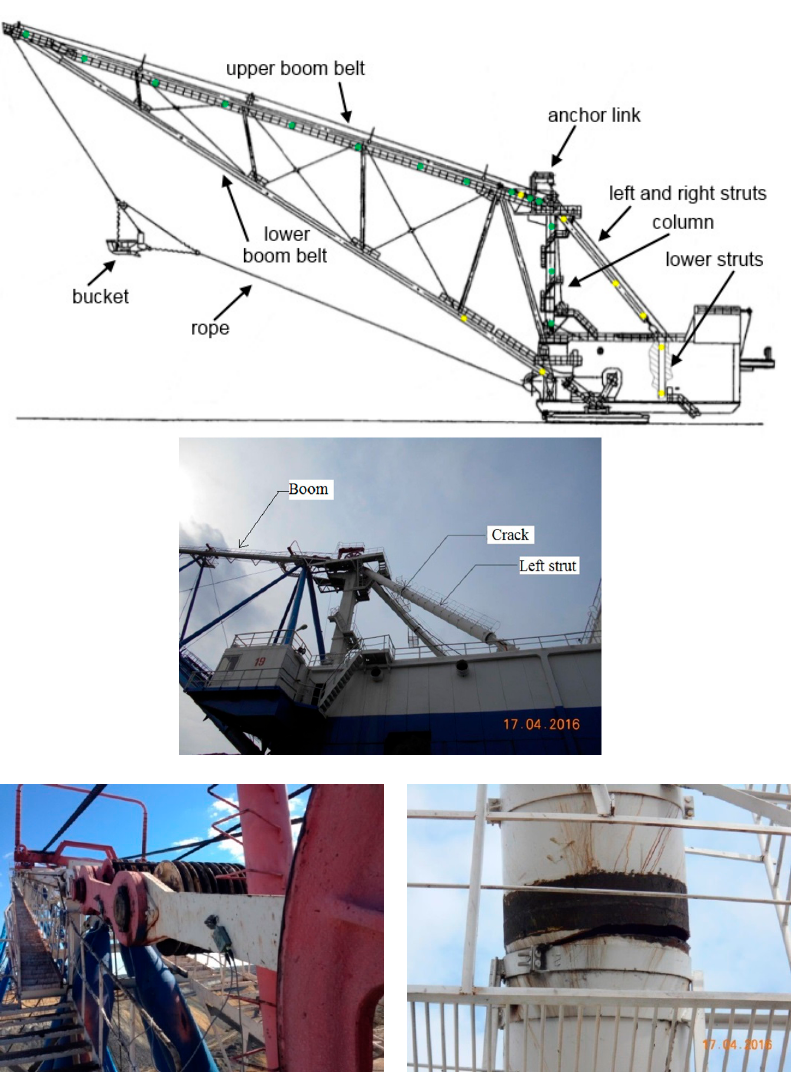
Figure 25. Tested dragline excavator.